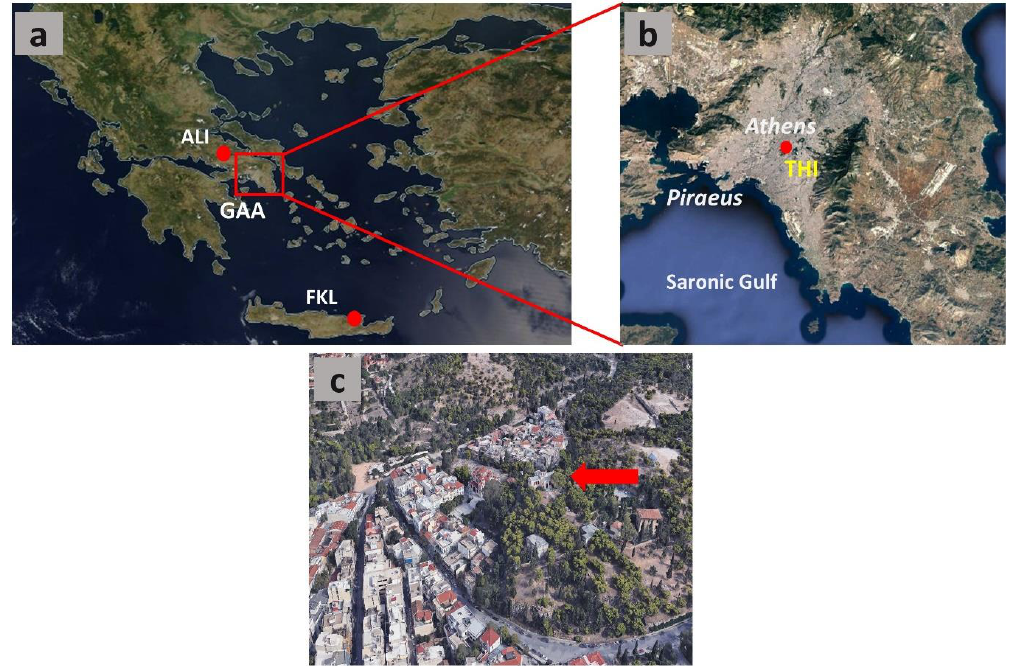
Figure 1. ( a ) Satellite overview of mainland and insular Greece, indicating the Greater Area of Athens (GAA) and the EMEP regional background sites of Finokalia, Crete (FKL) and Aliartos, Central Greece (ALI); ( b ) Overview of the GAA indicating the urban background Thissio (THI) site in the Athens basin; ( c ) Near view of the Thissio Air Monitoring Station atop the Nymphs Hill, in central Athens. Source: Google Earth, 10 August 2020.